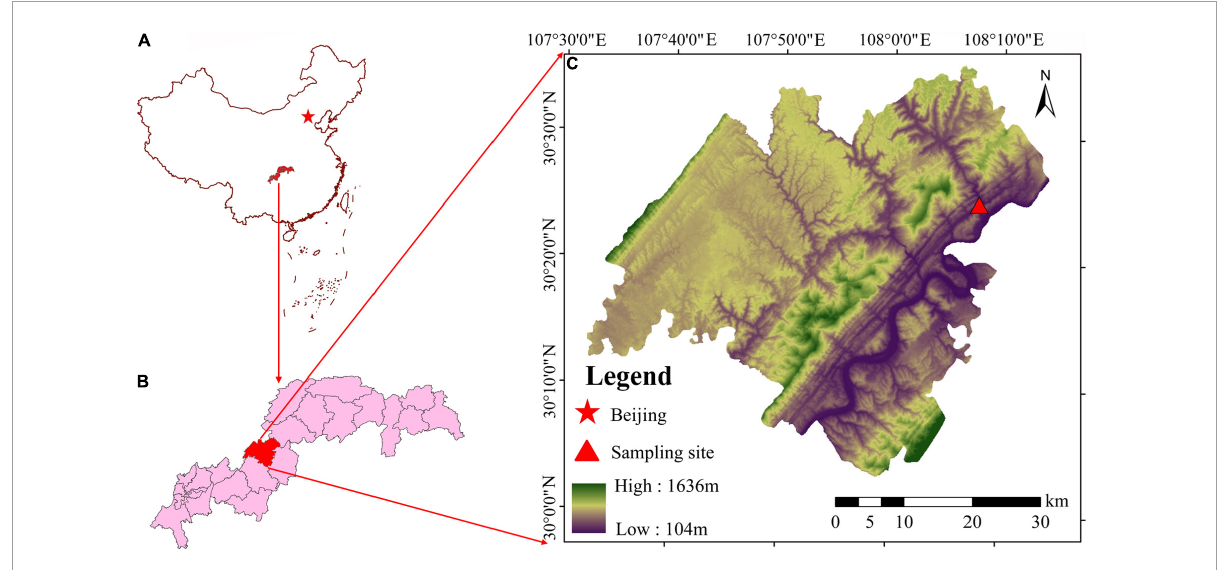
FIGURE1 The sample site (C) is located in the Three Gorges Reservoir (B) of China (A)